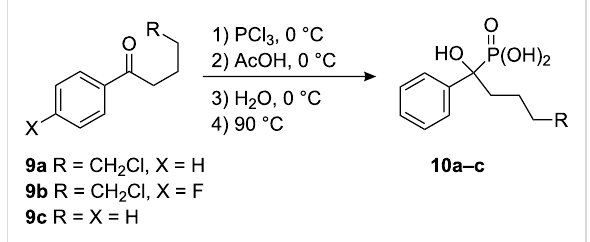
NMR spectra, the only phosphorus containing products in the reaction mixtures were the corresponding α -hydroxyphos- phonic acids 10 . Similarly, acid 10c is formed from phenyl- butanone 4c in 41%